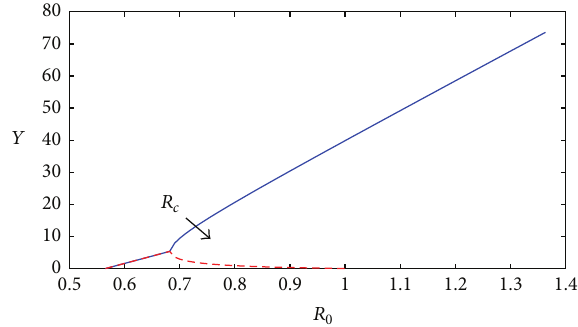
Figure 2: The sizes of population 𝑌 at equilibria versus 𝑆 1 with 𝑑 = 0.1 , 𝑎 = 0.001 , 𝑏 = 0.01 , 𝑐